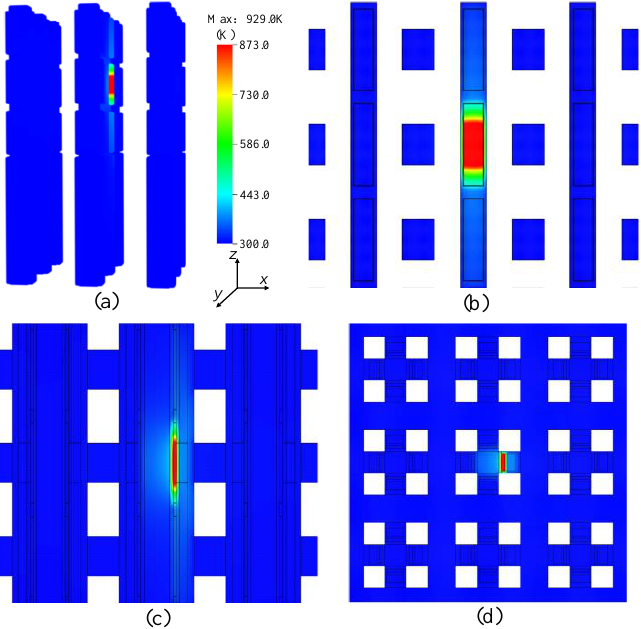
Figure 13. Temperature distributions of the PCM array composed of a four-fold unit with w GST = 12nm: ( a ) 3-D structure; ( b ) cross-section in the xz -plane; ( c ) cross-section in the yz -plane; ( d ) cross-section in the xy -plane.